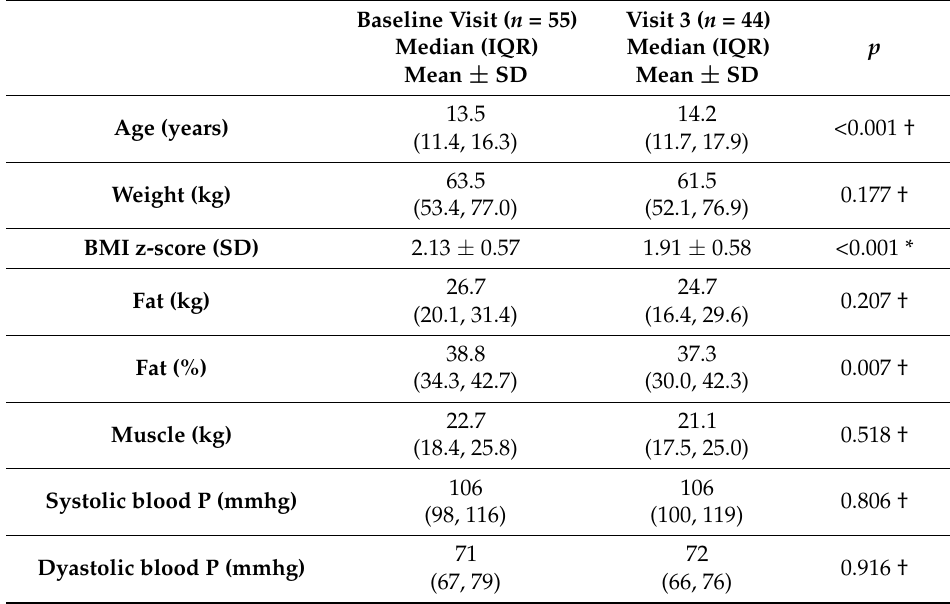
Table 1. Anthropometric characteristics in children in baseline and 3rd. visits.